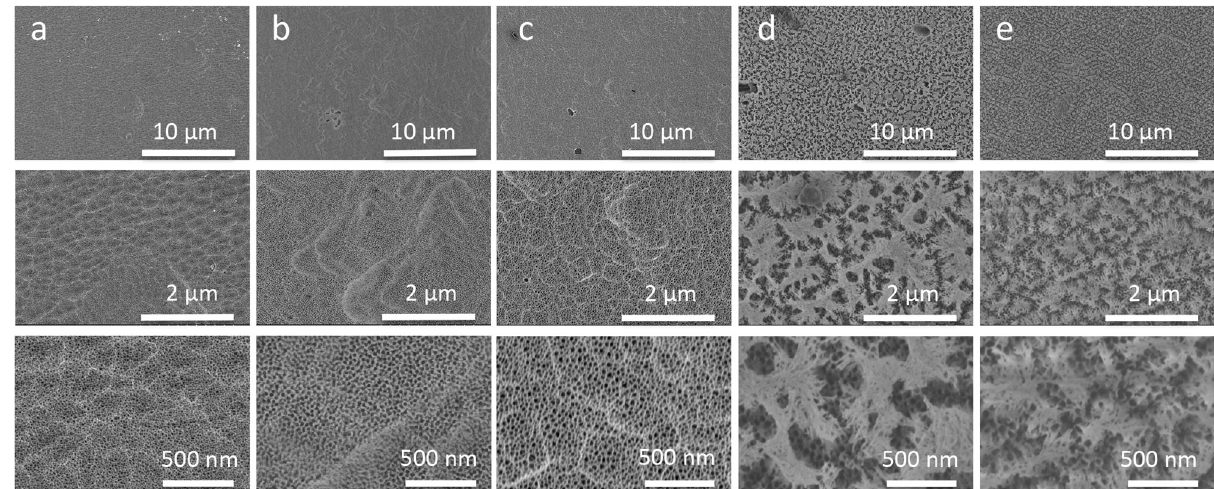
Fig. 1 Secondary electron SEM images of the surface morphology of anodic oxides produced by anodizing in: a SAA20, b SAA50, c PSA20, d PSA35, and e PSA50 (full experimental conditions are listed in Supplementary Table S1)